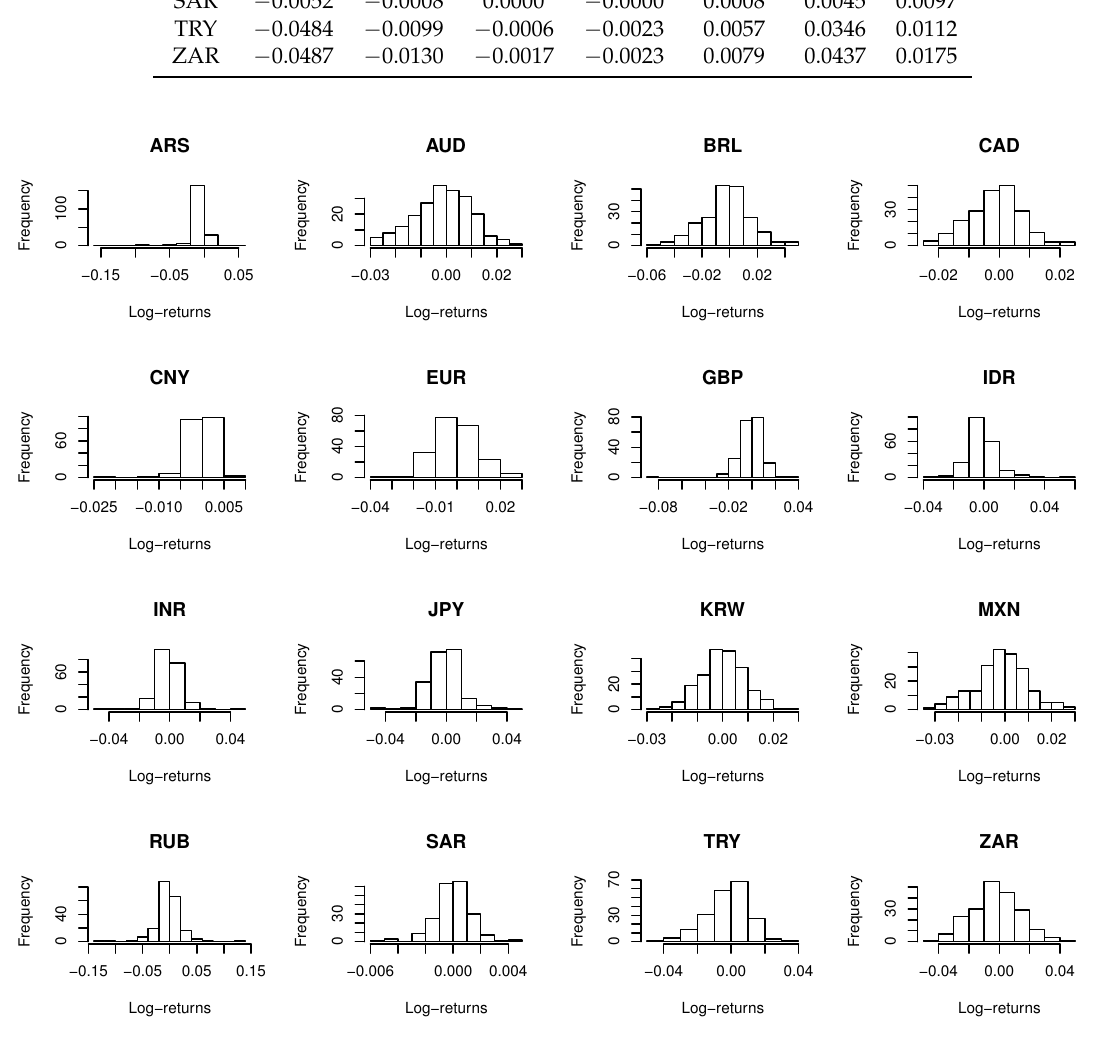
Figure 7. Histograms for the 16 selected